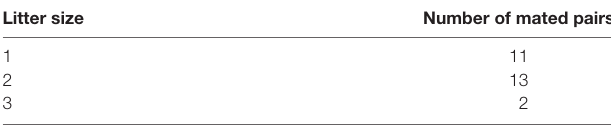
TABLE 1 | Litter size and number of primiparous California mouse mate pairs. Litter size Number of mated